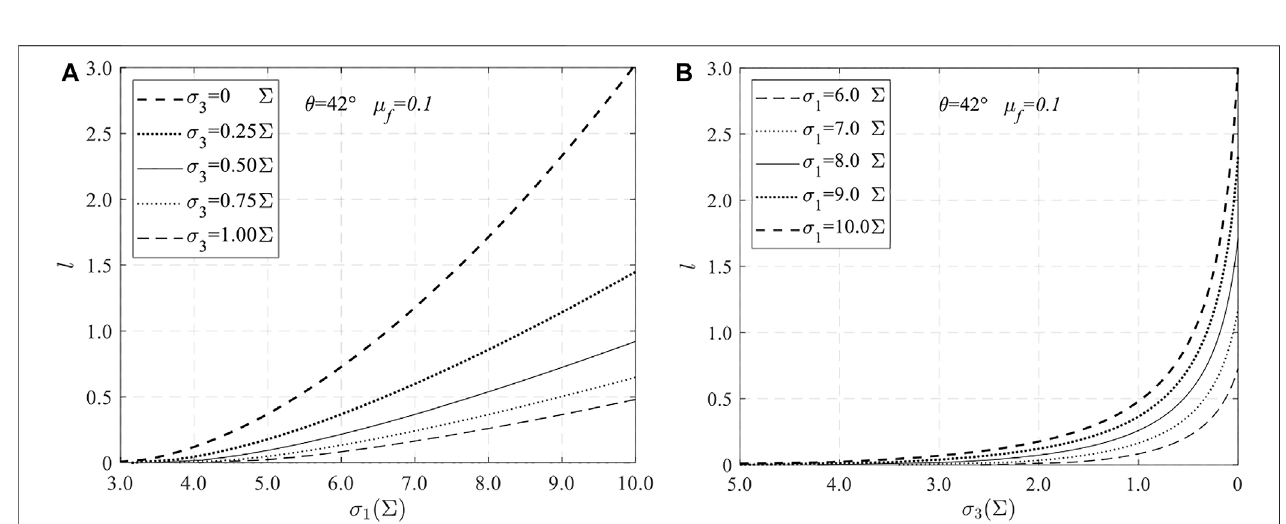
Frontiers in Earth Science |